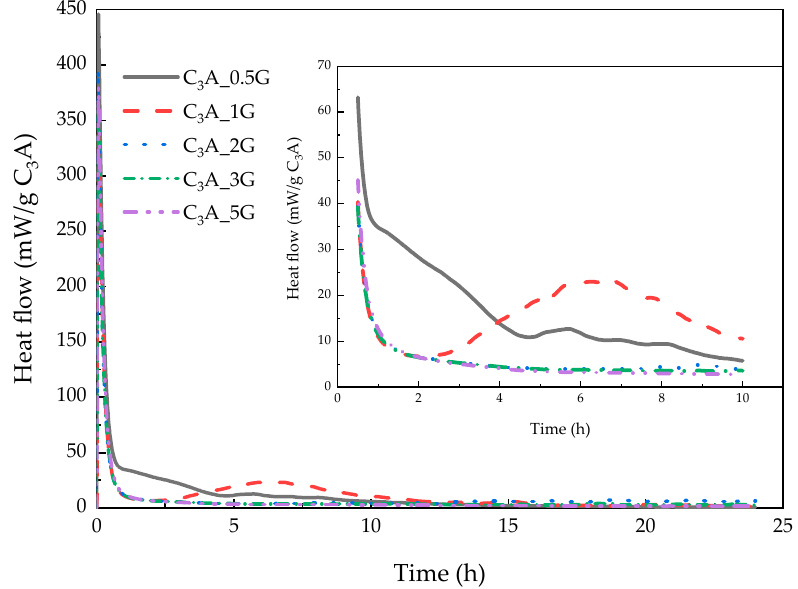
Figure 2. Heat evolution curves of C 3 A with various amounts of gypsum during the 24-h hydration.